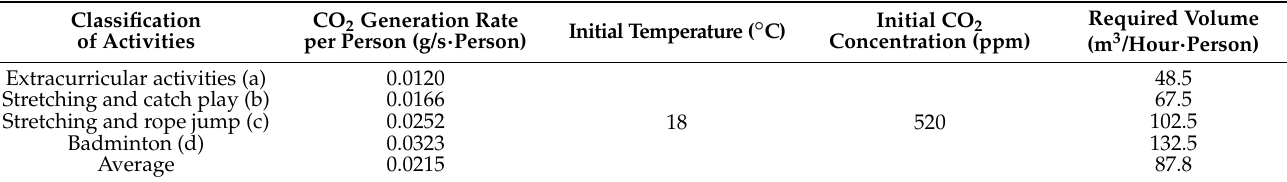
Table 12. Required volume per occupant based on the